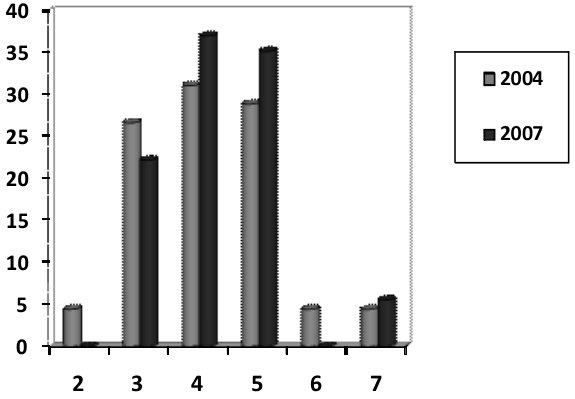
Figura 1 . Distribuição percentual dos Programas da Psico- logia por conceito nas avaliações trienais de 2004 e 2007 Apesar disso, há razões para pretendermos fazer avan- çar a qualidade da pós-graduação em Psicologia. A pri- meira delas é que nossos próprios indicadores de avalia- ção, com base nos critérios definidos pela área, mostram que apenas uma parte dos cursos alcançou um patamar de consolidação. Pouco mais de 40% dos cursos avalia- dos em 2007 (40,75%) alcançaram nota 5 ou superior 37,77%). Dentre os cursos que alcançaram a nota 5 e